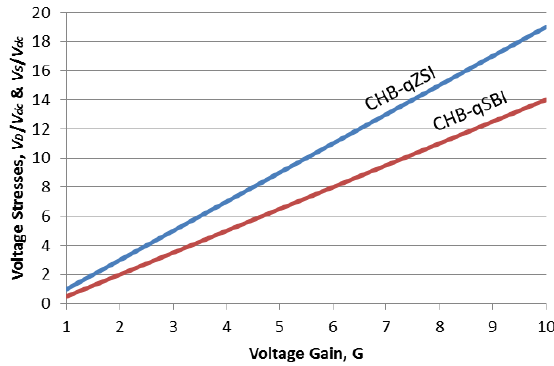
Figure 6. Voltage stress comparison for the same voltage gain.